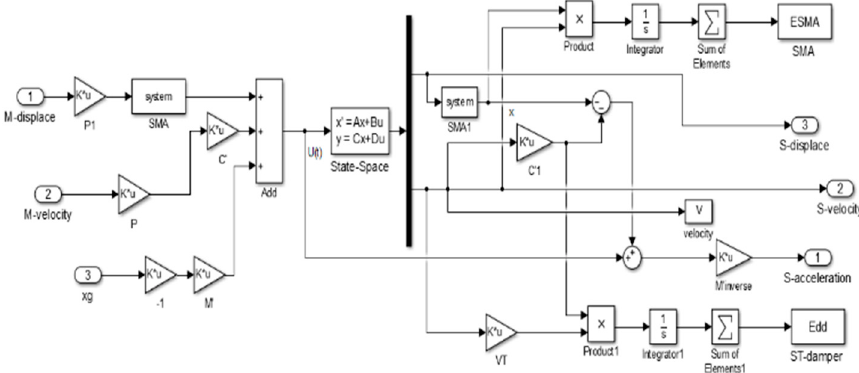
Figure 10. SMA-SPDS simulation model.